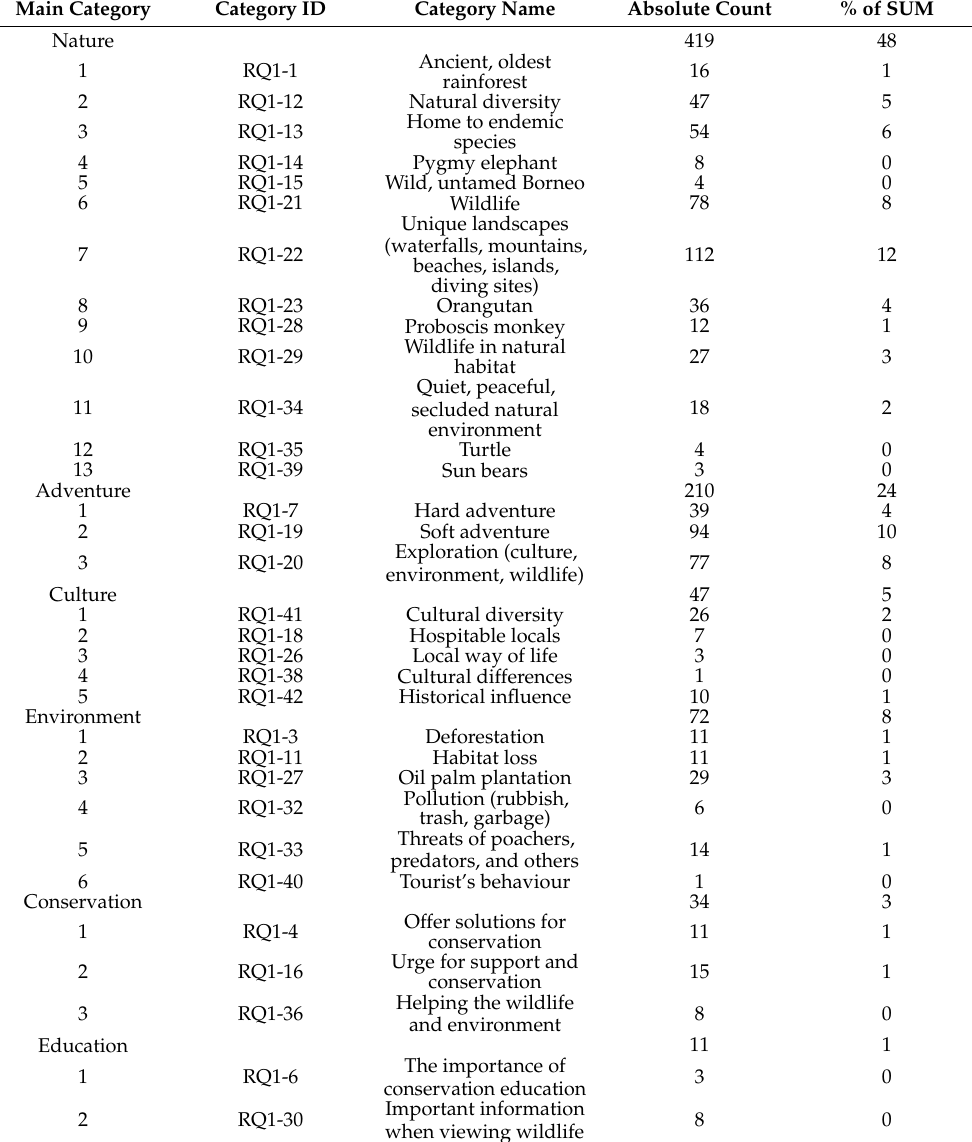
Table 2. Categorisation of sub-categories into main